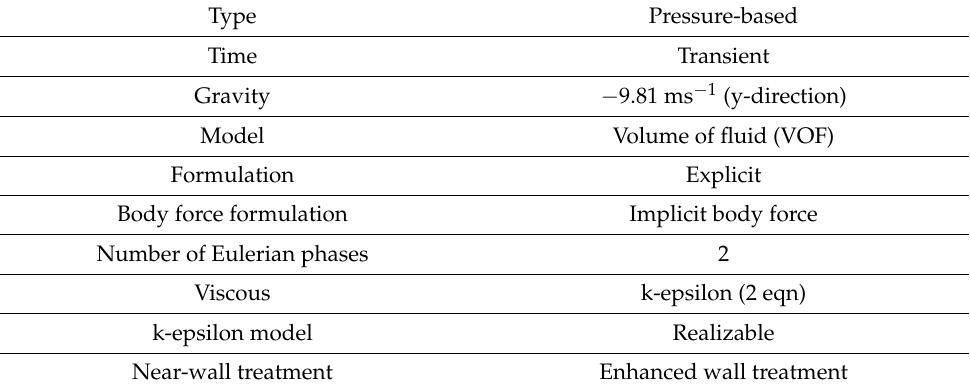
Table 2. General models.